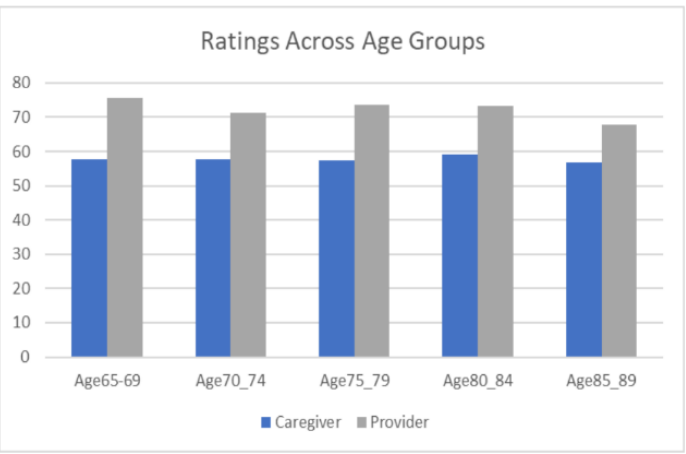
Figure 2. Ratings for scenarios as patients’ age range